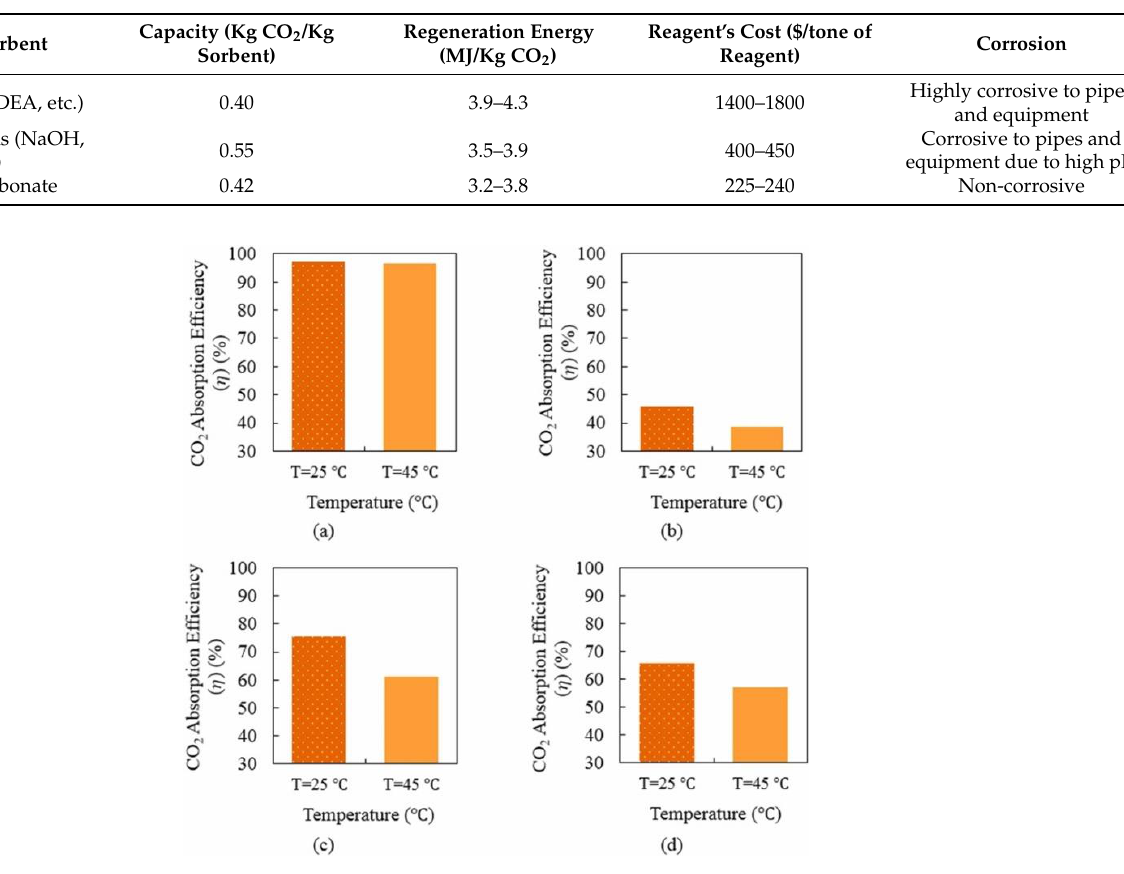
Figure 13. Effect of temperature and composition on the efficiency of CO 2 ( a ) [NaOH- GLY]: (0.5 M - 8 wt.%), Gas Flow Rat e = 10 0 mL/ min, ( b ) [NaOH- GLY]: (0.2 M - 8 wt.%), Gas Flow Rate = 200 mL/ min, ( c ) [NaOH- GLY]: (0.5 M - 4 wt.%), Gas Flow Rate = 200 mL/ min, ( d ) [NaOH-GLY] with permission of [142].